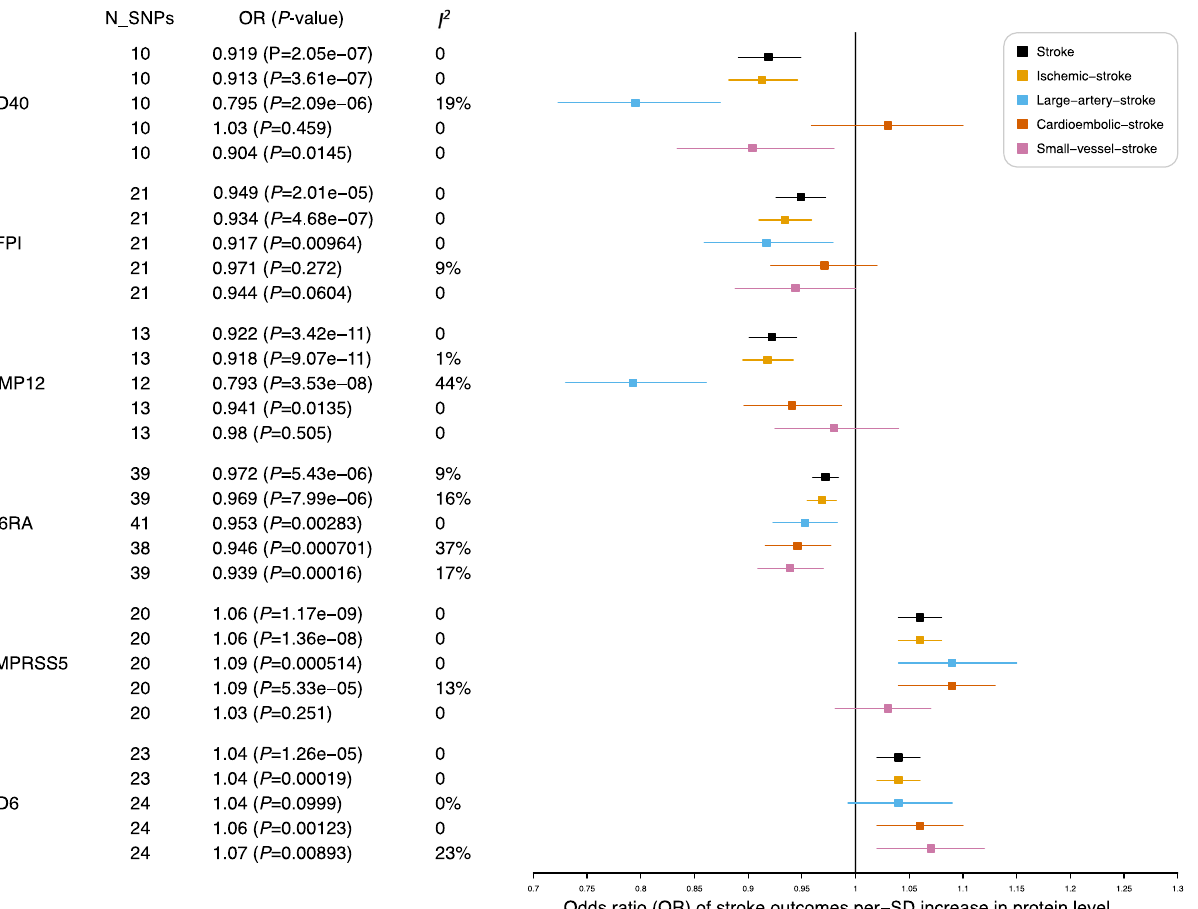
Fig.3 |Effectsofsixpotentialcausalproteinsonstrokeoutcomes. MRanalyses of the effect of proteins on stroke outcomes. The squares are the causal estimates on the OR scale, and the whiskers represent the 95%con fi dence intervals for these ORs. N_SNPs: number of SNPs used for the estimation of the causal effects in this plot. P valuesweredeterminedfromtheinverse-variance-weightedtwo-sampleMR